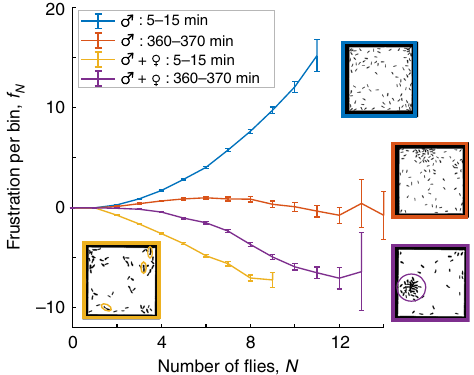
Fig. 4 Extracting frustrations to quantify changing behavior. Frustrations measured for fl ies in a 4 cm square chamber. The experiment duration was seven hours. The frustrations were extracted from two different 10 minute intervals corresponding to the initial and fi nal stages of experiments on two different populations. The blue curve (90 ♂ ) exhibits a positive curvature at all occupancies, indicating an aversion to crowding at all densities. The red curve characterizes interactions for the same population 6 hours later. The lower curvature indicates signi fi cantly reduced aversion to grouping. The yellow curve (30 ♂ + 25 ♀ ) exhibits a downward curvature at low occupations, re fl ecting mating interactions between pairs of fl ies (yellow ellipses). At higher occupancies, the lack of curvature indicates a more neutral response to changes in occupation number. Finally, the purple curve characterizes interactions for the same mixed-sex population 6 hours later. The downward curvature shifts to higher occupancies and is followed by a region of positive curvature. The corresponding in fl ection point indicates a preference for group formation with a density of about eight fl ies per bin. S. d. error bars calculated from the maximum likelihood (ML) covariance matrix of DFFT distribution in Eq.